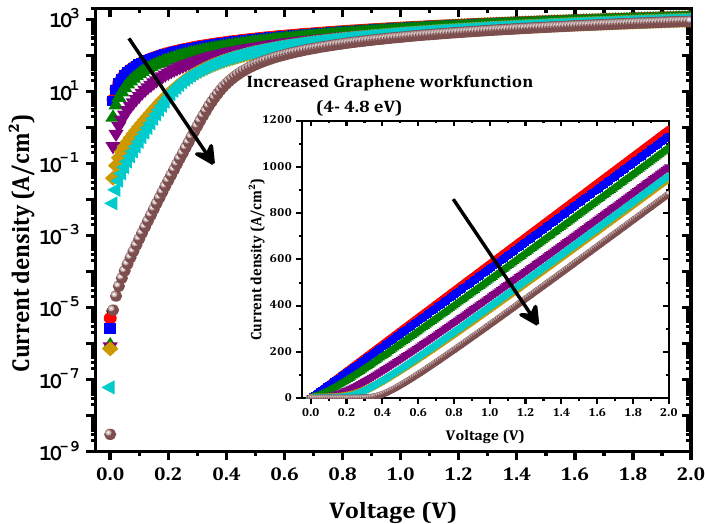
Figure 9. Output J-V variation versus the graphene workfunction. The inset is a linear representation of the J-V characteristics.